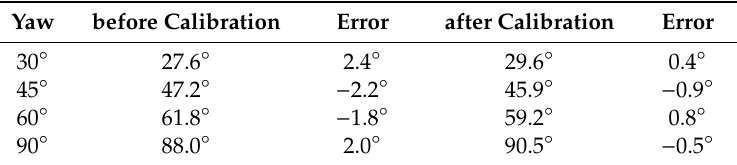
Table 4. Experimental results of heading angle